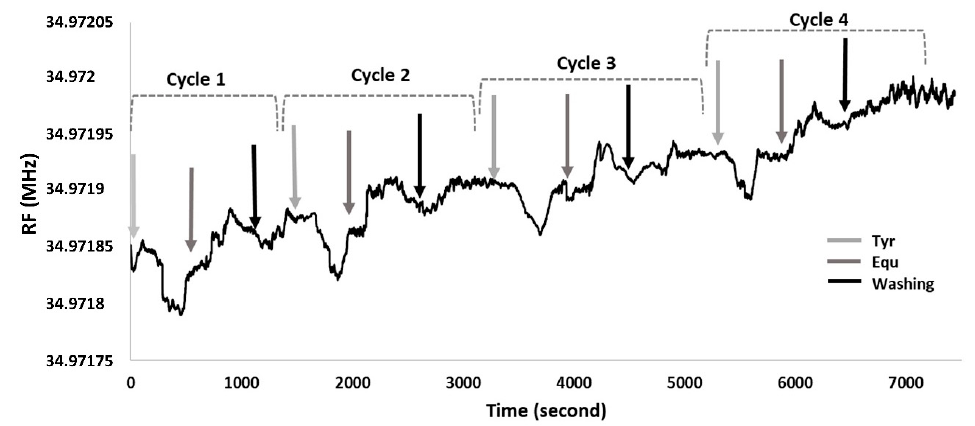
Figure 8. QCM nanosensor